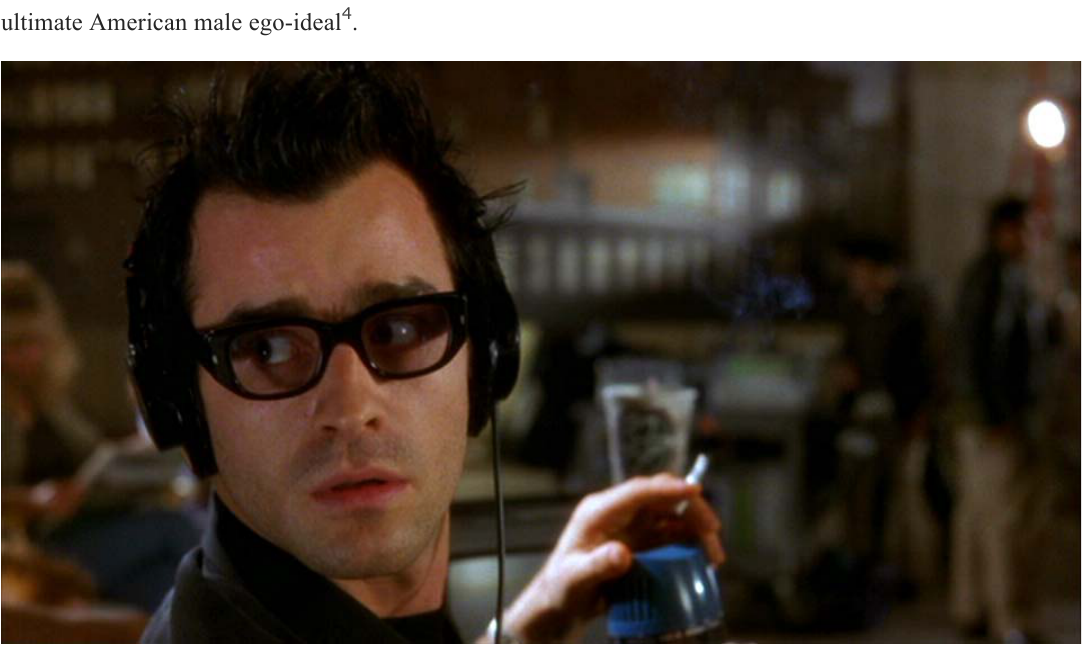
Figure 6: Adam (Justin Theroux) , the film director in Diane’s fantasy, is under constant threat from ‘the